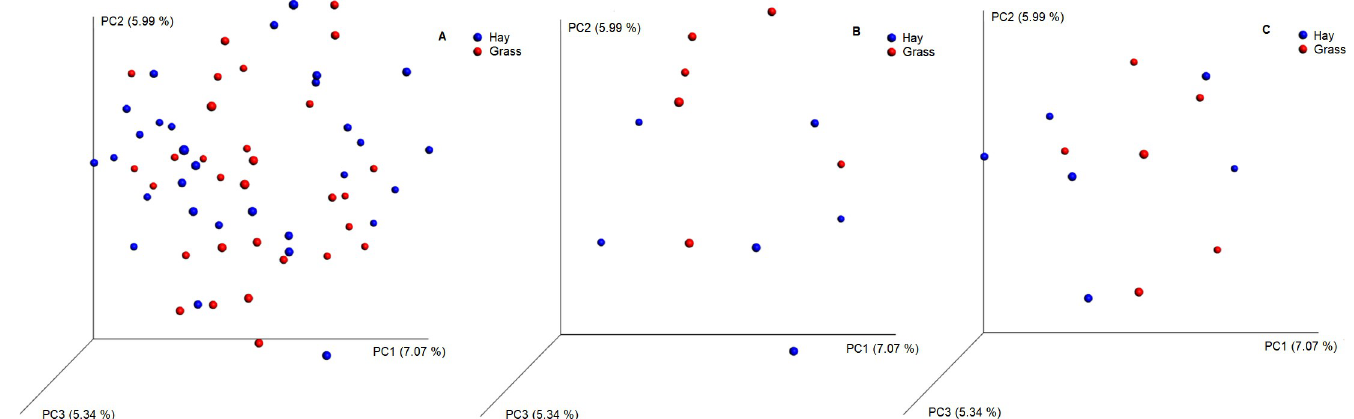
Fig 4. PCA on an unweighted-UniFrac dissimilarity matrix for data on the microbial membership and structure in the faeces of ponies. (A) Days 1, 2, 3, 7, 14 on grass and hay (H-D1, H-D2, H-D3, H-D7, H-D14, G-D1, G-D2, G-D3, G-D7, G-D14) (B) Day 1 after abrupt change on grass and hay (H-D1, G-D1) (C) Day 3 after abrupt change on grass and hay (H-D3, G-D3). OTUs with < 100 reads were excluded from the analysis. n = 6. H: hay; G: grass; D: day; PCA: Principal coordinate analysis. https://doi.org/10.1371/journal.pone.0237869.g004 between grass and hay diets (LDA score > 2, P < 0.05). Overall, there were 2 phyla, 3 classes, 9 orders, 18 families and 31 genera that were identified as different on day 14 when ponies were receiving hay or grass diets (H-D14 and G-D14).